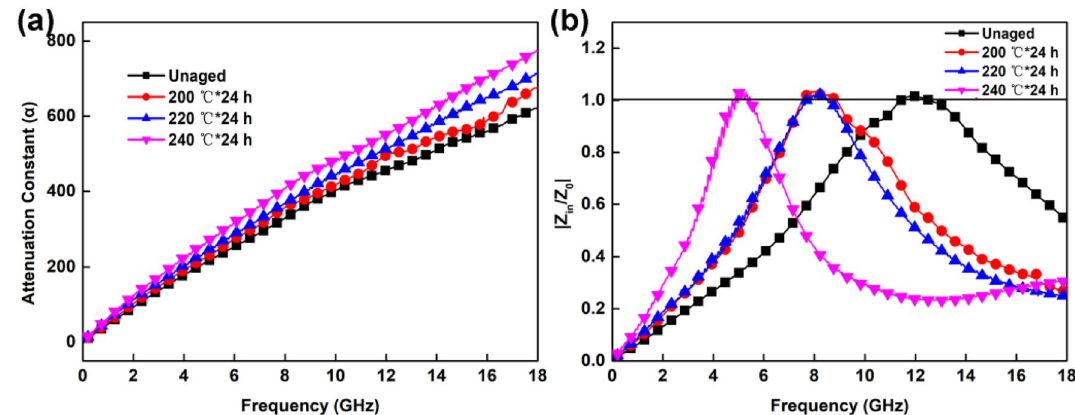
Figure 9. The attenuation constant ( a ) and | Z in / Z 0 | ( b ) of the composites aged at different temperatures. Microwave absorbing material